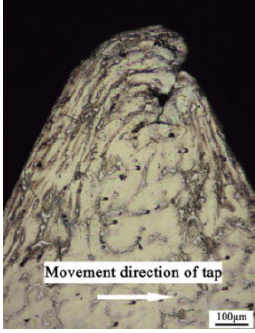
Figure 11. Optical image of the thread profile.